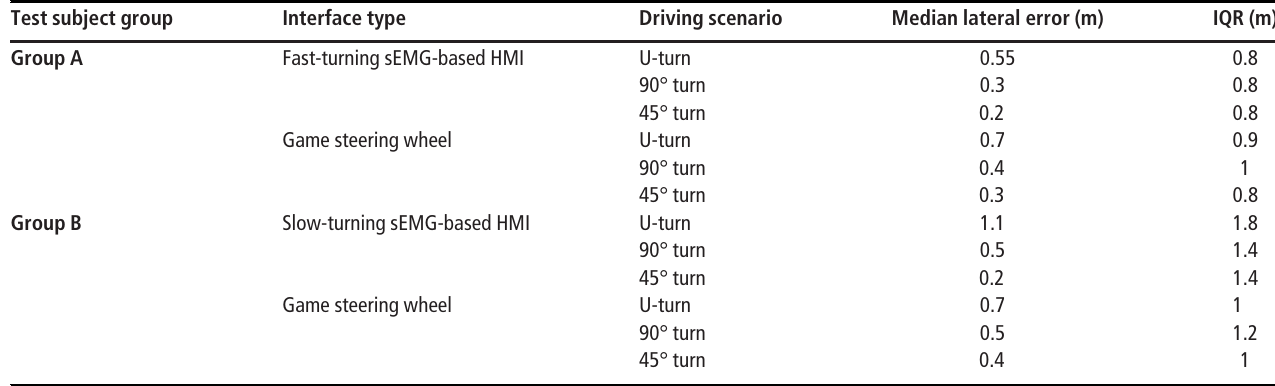
Table II Summary of path-following accuracy